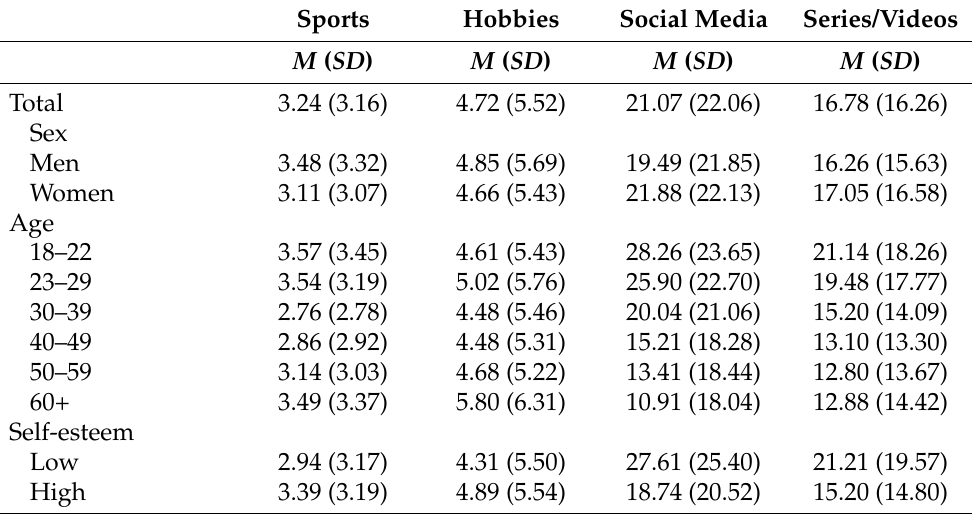
Table 2. Average hours per week of sports, hobbies, social media, and series by sex, age, and different levels of self-esteem, self-control, and emotional